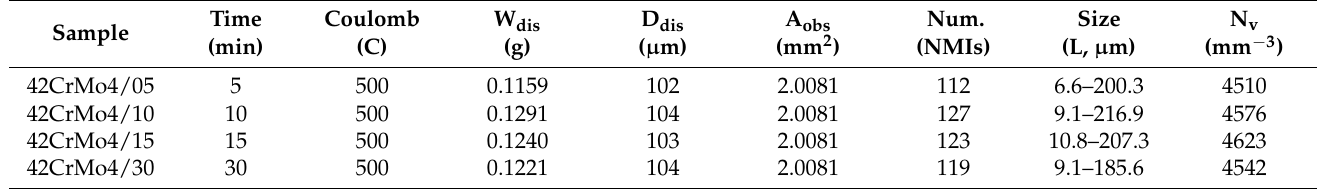
Table 9. Main parameters of EE and SEM observations of elongated sulfides in different steel samples of 42CrMo4 steel grade after heat treatment using Method 2.